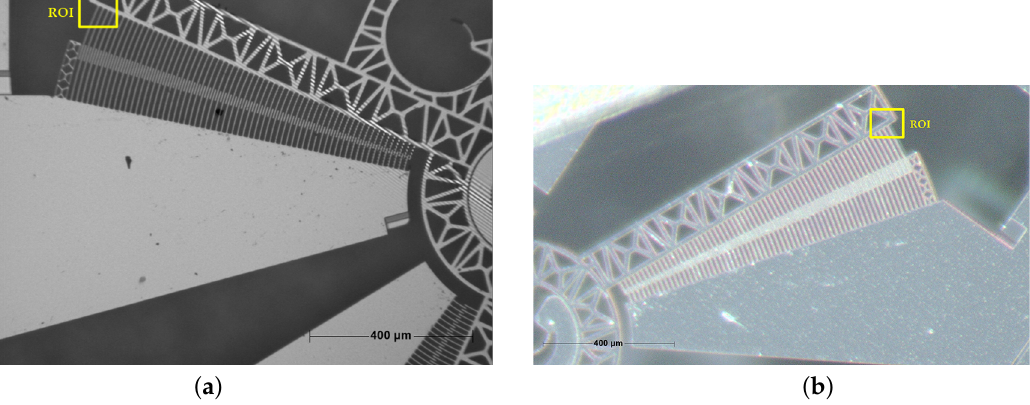
Figure 7. Manual selection of a particular region of the image (ROI), to find its center of gravity (COG) on OPS image ( a ) and on LTM image ( b